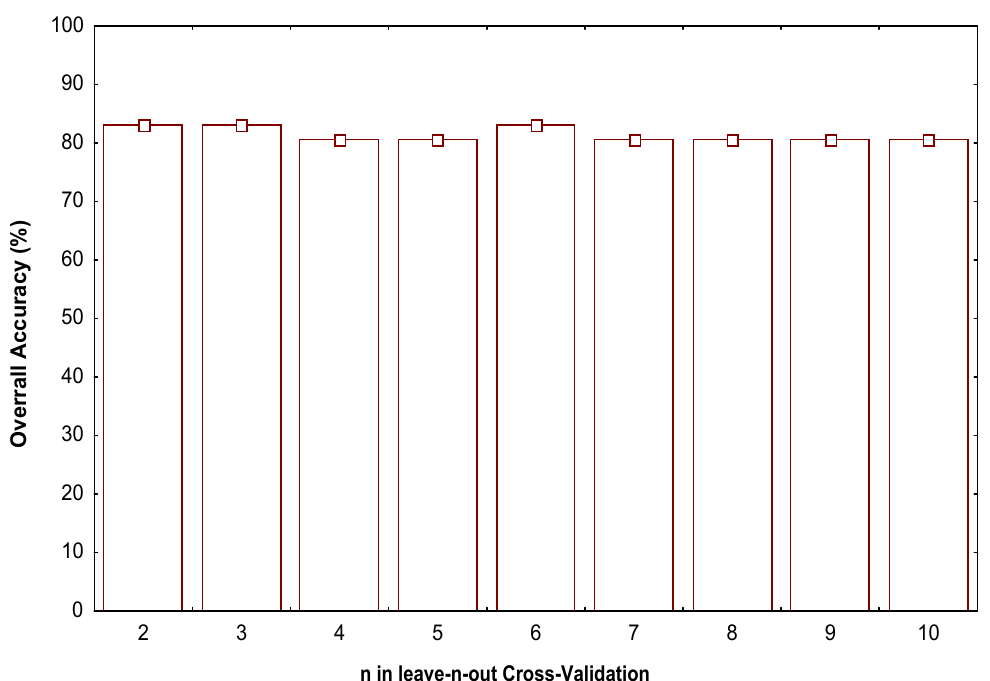
Figure 1. Behavior of the global or total percentage of good classification (accuracy) in different n -fold cross-validation